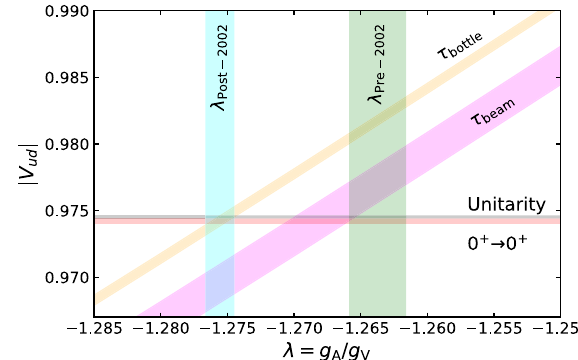
Figure 4. Mean lifetime values from beam and bottle experiments are plotted against pre- and post-2002 values of λ , the value of | V | from superallowed Fermi-decays, and the ud assumption of unitarity.